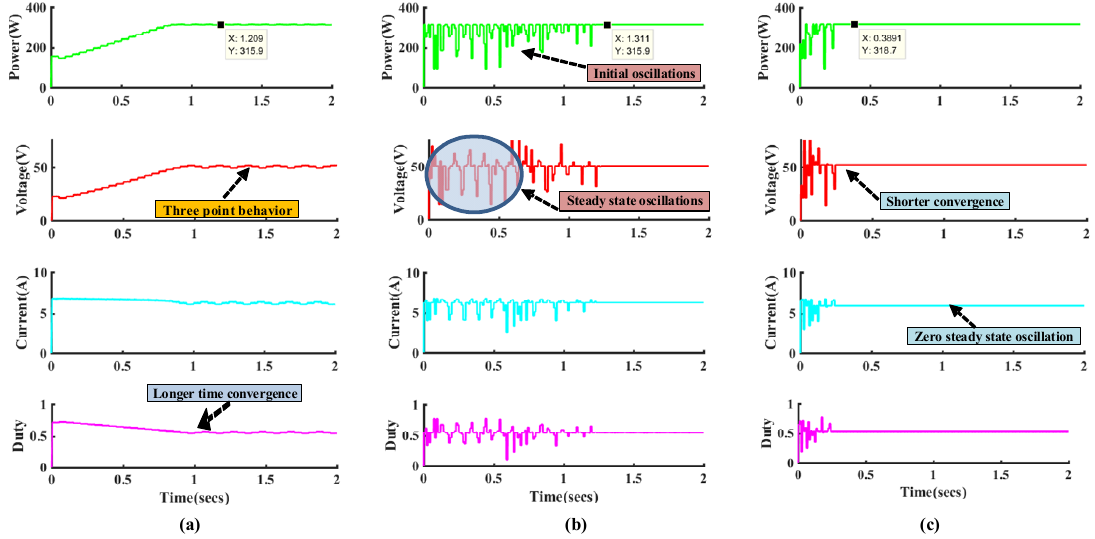
Figure 11. Simulated waveforms of ( a ) P&O, ( b ) PSO and ( c ) SHO methods for Pattern 2.